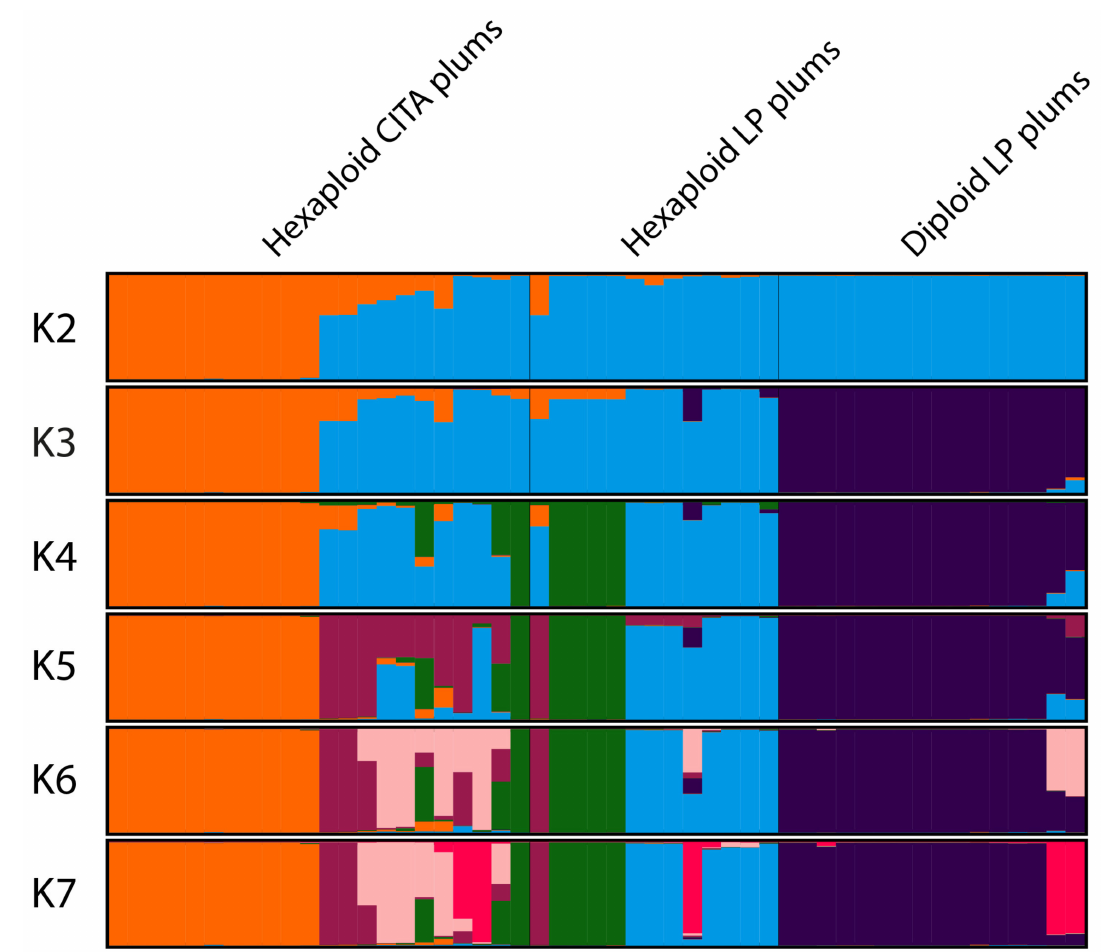
Figure 4. Bar plot of Prunus species inferred from Bayesian cluster STRUCTURE-CLUMPAK analyzed with Q = 20 repetitions for K = 2 to K =